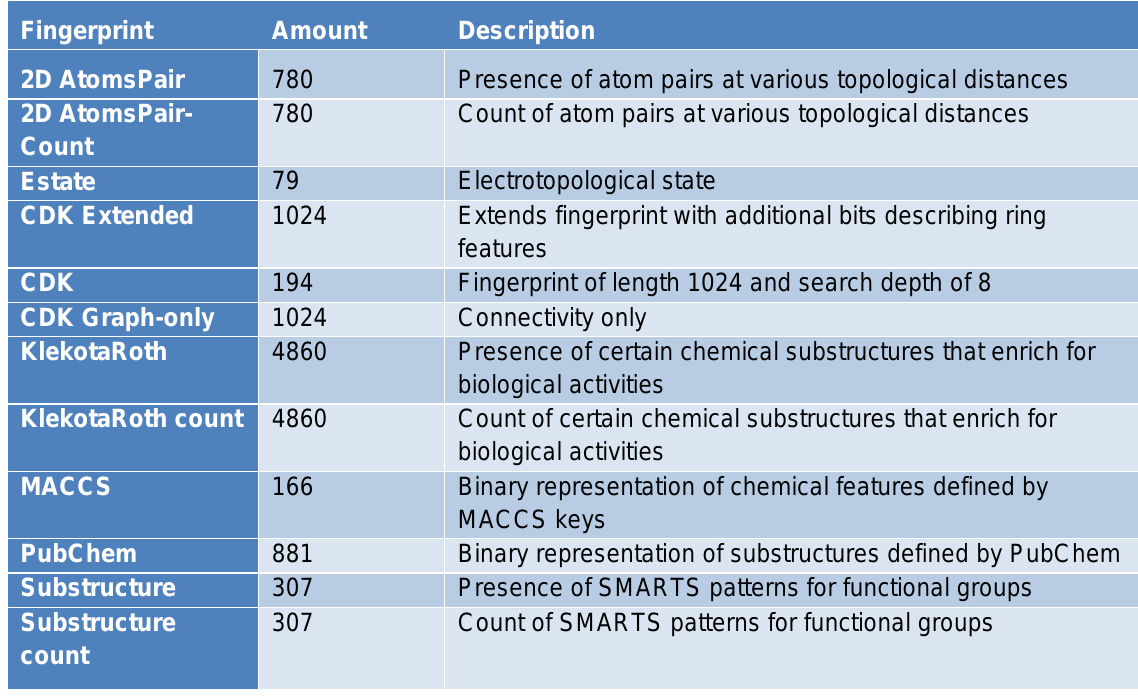
Table 2: All 12 sets of molecular fingerprints in PaDEL software